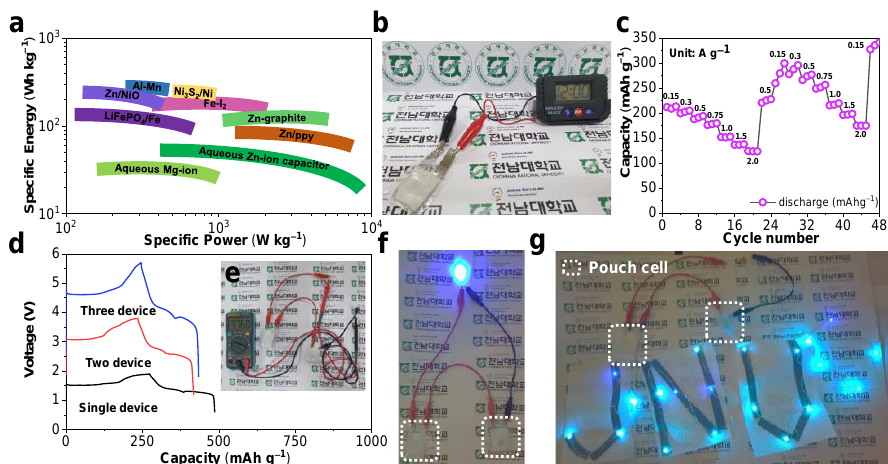
Figure 5. ( a ) Ragone plot of the Zn/ZnO battery compared with other reported battery devices, ( b ) selected charge/discharge patterns for the Zn/ZnO pouch battery cycled at different rates in ZMS electrolyte, ( c ) rate performance of the single-pouch Zn/ZnO battery, ( d ) galvanostatic charge/discharge profiles measured at a current density of 100 mA g − 1 of a single-pouch battery and tandem devices with two- and three-battery units allied in series, ( e ) digital photograph representing the output voltage (3.7 V) of a two-pouch Zn/ZnO battery connected in series (after the 5th charge), ( f ) digital photograph of a single LED powered by a two-pouch Zn/ZnO battery connected in series, and ( g ) digital photograph of 1 m long serial LEDs powered by a two-pouch Zn/ZnO battery connected in series. (Explanation in Korean in the backround represents Chonnam National University).